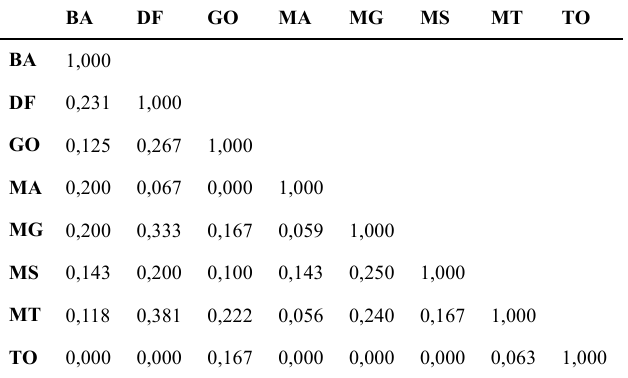
Table 5. Similarity matrix (Jaccard) of species from the Mischocyttarus genus for the 8 studied states (BA = Bahia; DF = Distrito Federal; GO = Goiás; MA = Maranhão; MG = Minas Gerais; MS = Mato Grosso do Sul; MT = Mato Grosso; TO =